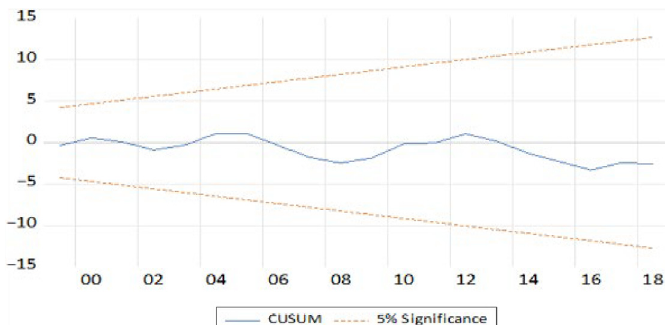
Figure 1. Cumulative sum of recursive residuals